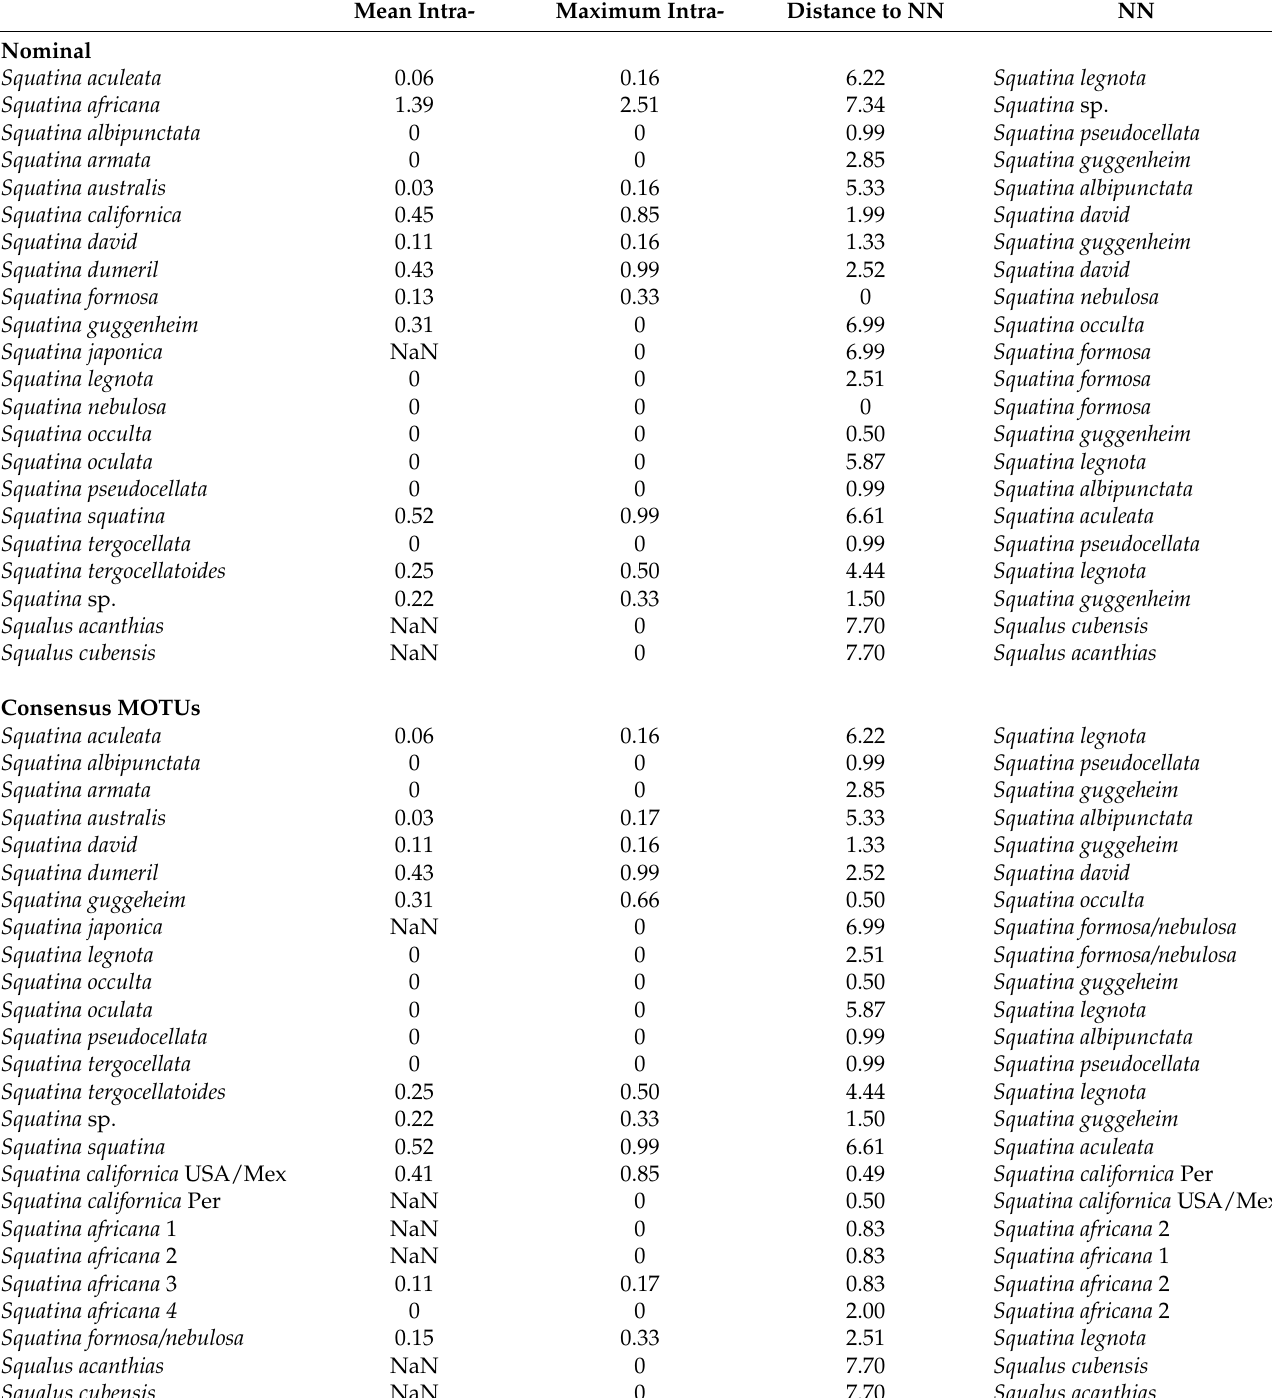
Table 3. Genetic K2-P distances of MOTUs and nominal species of angel sharks: mean intra-MOTU divergence (mean intra-), maximum intra-MOTU divergence (maximum intra-), distance to the nearest neighbor (distance to NN) and the nearest neighbor